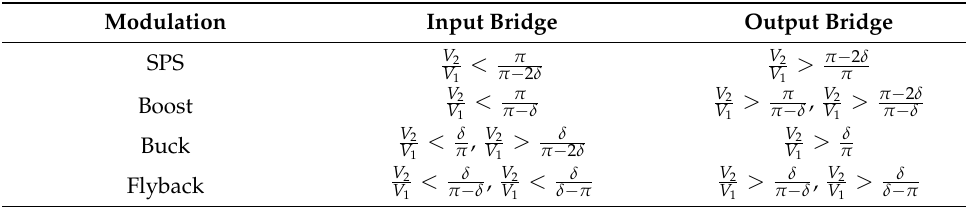
Table 4. Soft switching